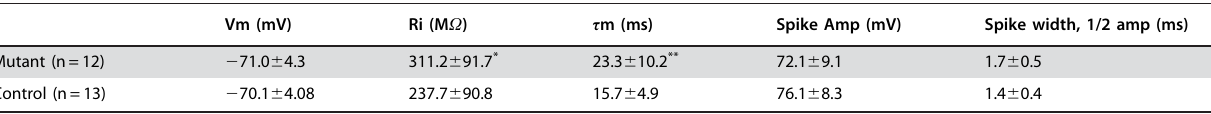
Table 1. Comparison of electrophysiological properties between pyramidal neurons of mutant and control neocortex. .. ... .... ... ... .... ... ... .... ... ... .... ... ... .... ... ... .... ... ... .... ... ... .... ... ... .... ... ... .... ... ... .... ... ... .... ... ... .... ... ... .... ... ... . Vm (mV) Ri (M V ) t m (ms) Spike Amp (mV) Spike width, 1/2 amp (ms) Mutant